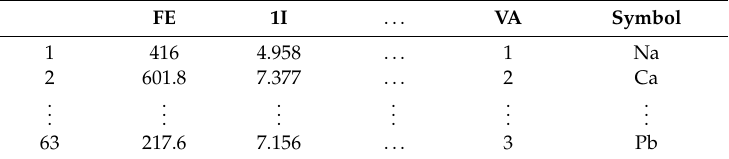
Table 2. Data file for data-mining techniques.